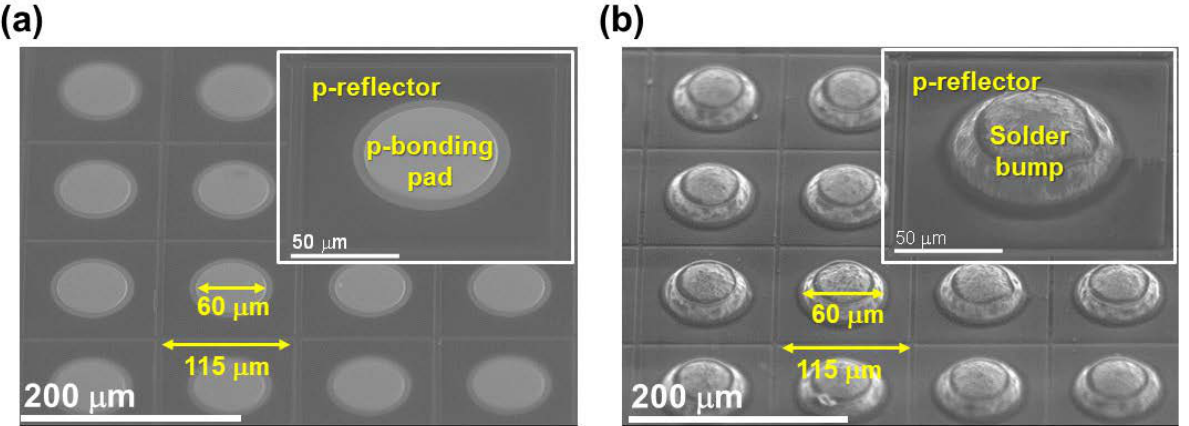
Figure 3. Top-view high-resolution FE-SEM cross-sectional images of fabricated μ-LED arrays ( a ) without and ( b ) with a 50 μm solder bump on the p-bonding pad. Inset shows without/with solder bump for one pixel.